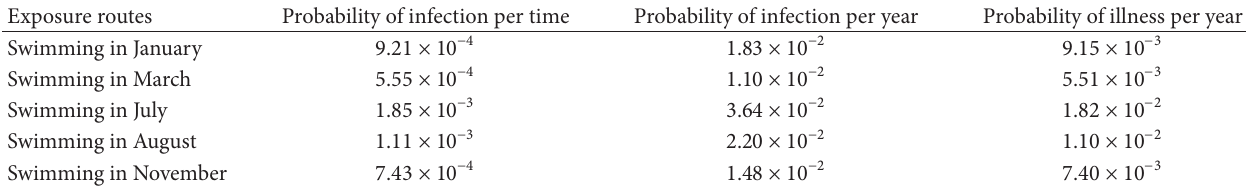
Table 4: Simulated risks by exposure events in Yunlong Lake (swimming).